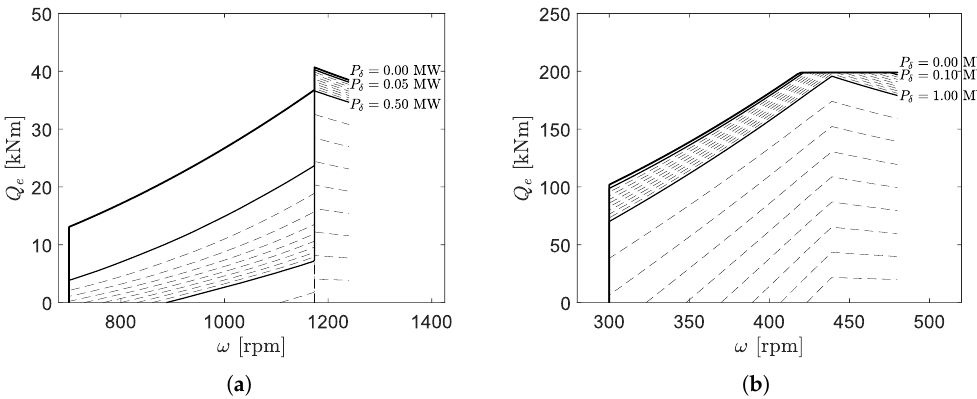
Figure 18. Q e ( ω , P δ ) tables for NREL 5-MW ( a ) and DTU 10-MW ( b ) reference